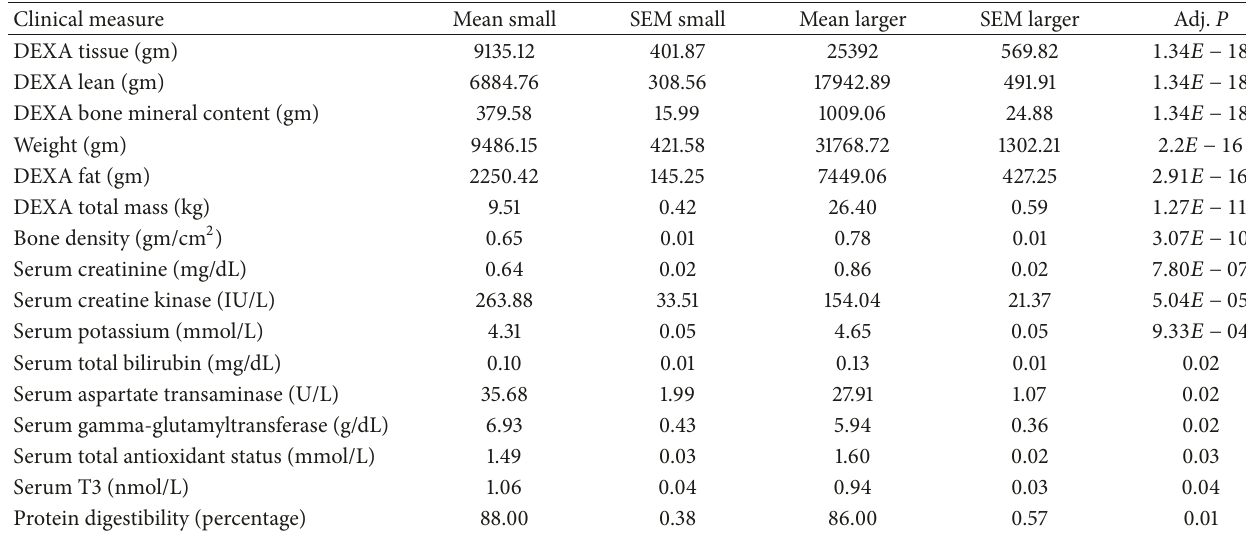
Table 2: Clinical measures with adjusted 𝑃 value < 0.05 between small dogs and dogs of larger body